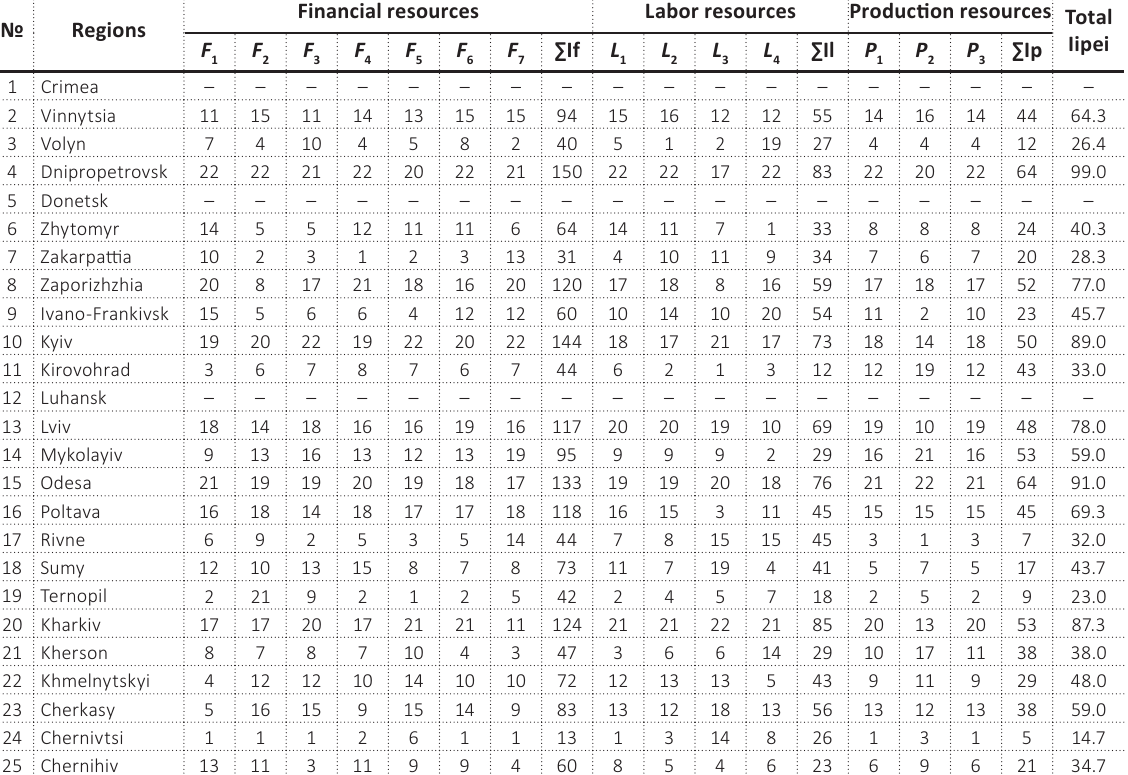
Table D1. Rating positions of Ukraine’s regions according to their provision with economic (financial,